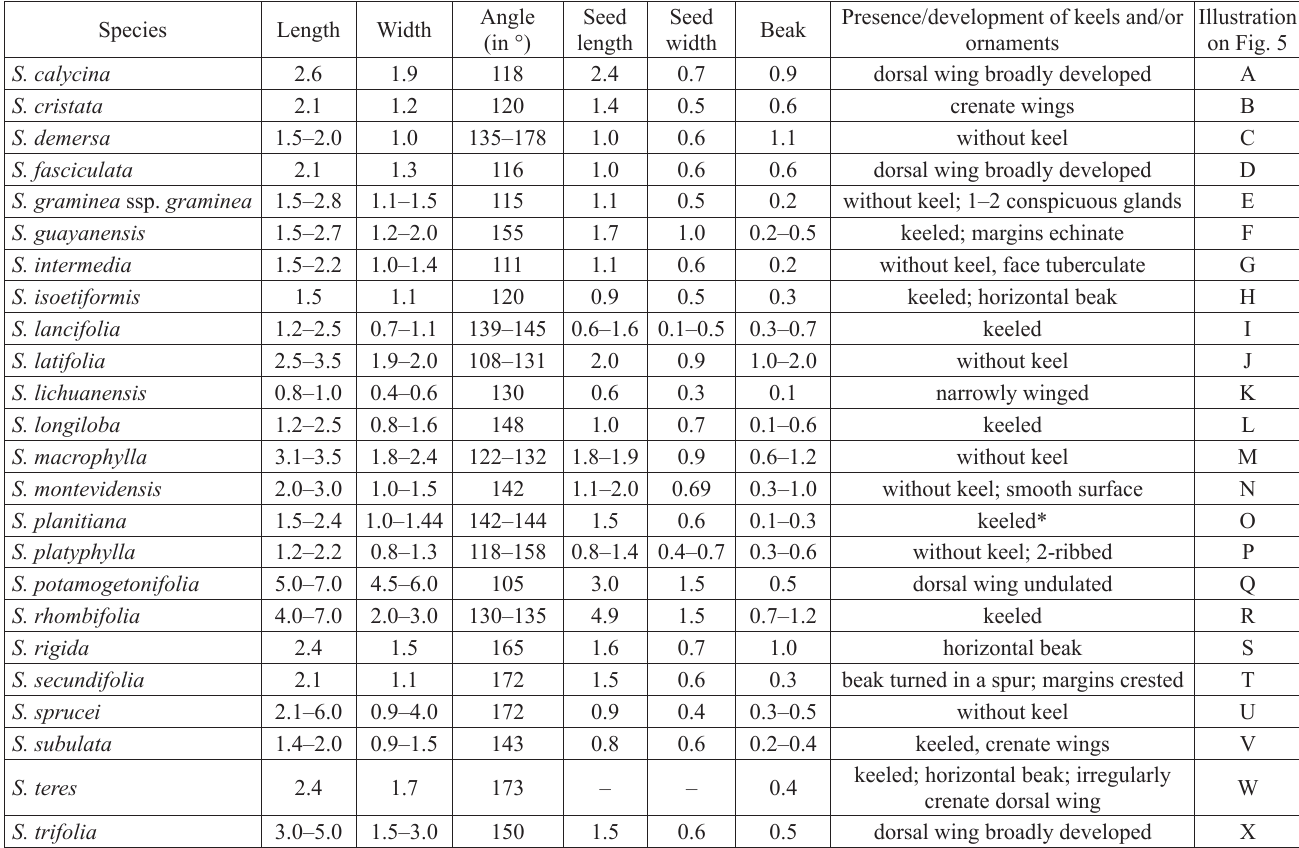
Table 2. Comparative chart (measurements in mm) of current Sagittaria fruits. Data obtained from: Smith (1895); Den Hartog (1957); Godfrey and Adams (1964); Rataj (1970, 1978); Wooten (1973); Kral (1982); Haynes and Holm-Nielsen (1994); Zepeda and Lot (1999); Matias and Ir- gang (2006); Moreira and Bove (2010); Wang et al. (2010); Matias and Sousa (2011); Lim (2015); Hall and Gil (2016); Canalli and Bove (2017); Ricketson (2018). *, authors differ in this character; –, the dimension could not to be established.